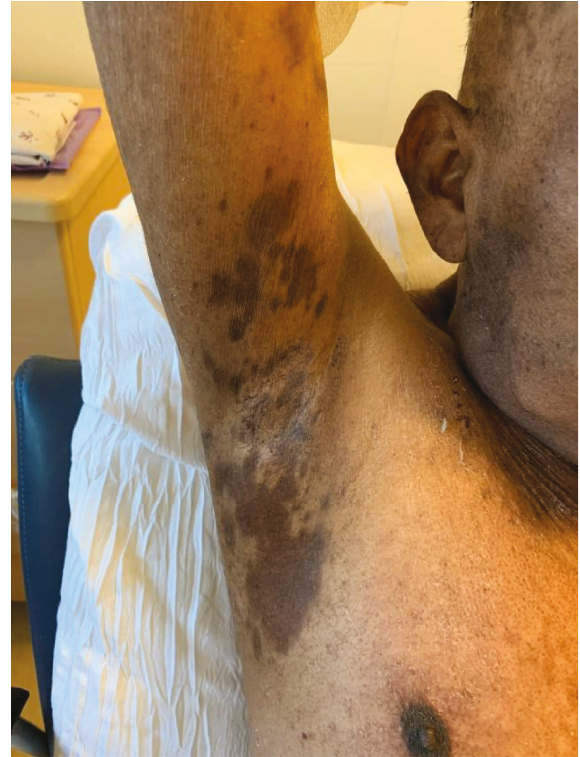
Figure 5: Resolution of axillary involvement after two months of treatment.